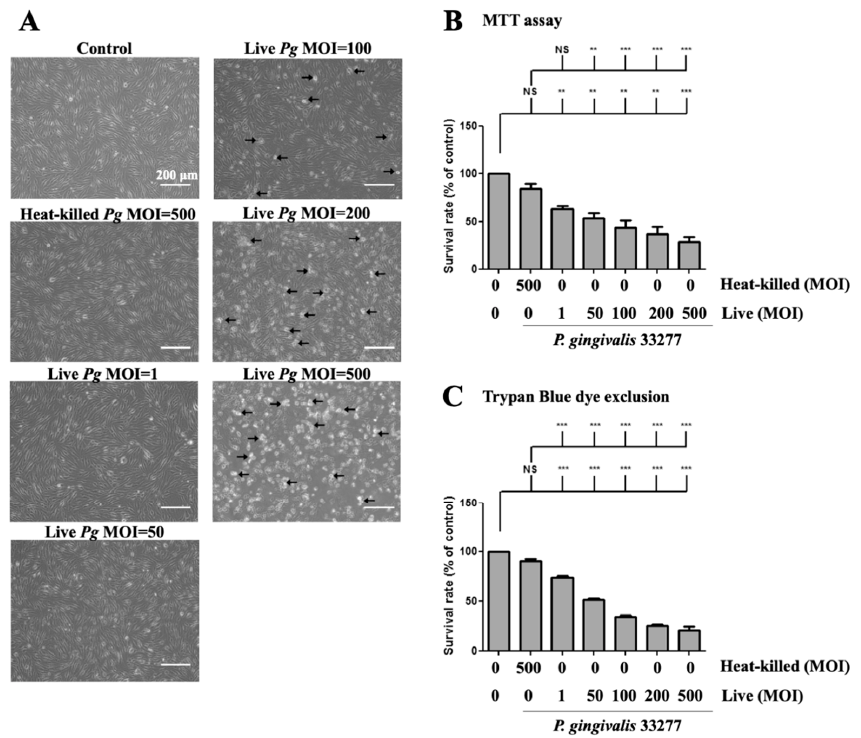
Figure 2. P. gingivalis caused cell morphological changes and cell death in brain endothelial cells. bEnd.3 cells are infected with live (1, 50, 100, 200 or 500 MOI levels) or heat-killed (500 MOI level) P. gingivalis for 90 min and further incubated with fresh medium for another 24 h. ( A ) Cell morphology is observed with a light microscope. The arrows indicate the death cells. The scale bar represents 200 µ m. The cell survival rate is determined by the MTT assay ( B ) and Trypan Blue exclusion test ( C ) and calculated as the percentage of control. Data are presented as mean values ± SEM ( n = 4). **, p < 0.01; ***, p < 0.001; NS, p > 0.05 indicate significant differences compared to the control or heat-killed P. gingivalis group.